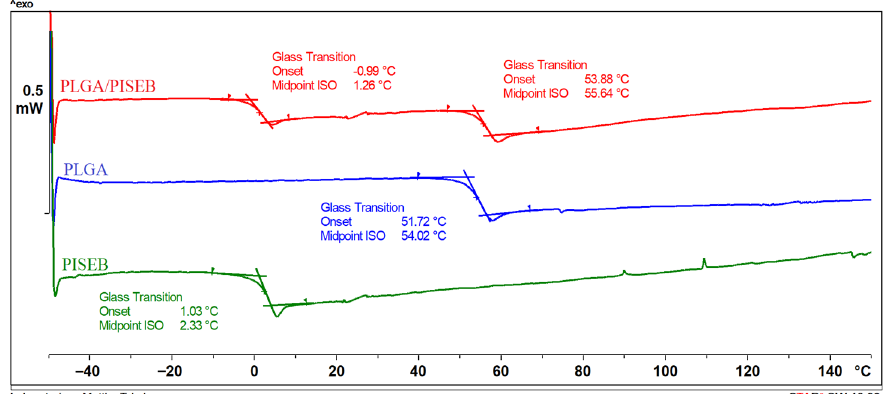
Figure 4. DSC second heating run of PISEB, electrospun PLGA and PLGA/PISEB blend.